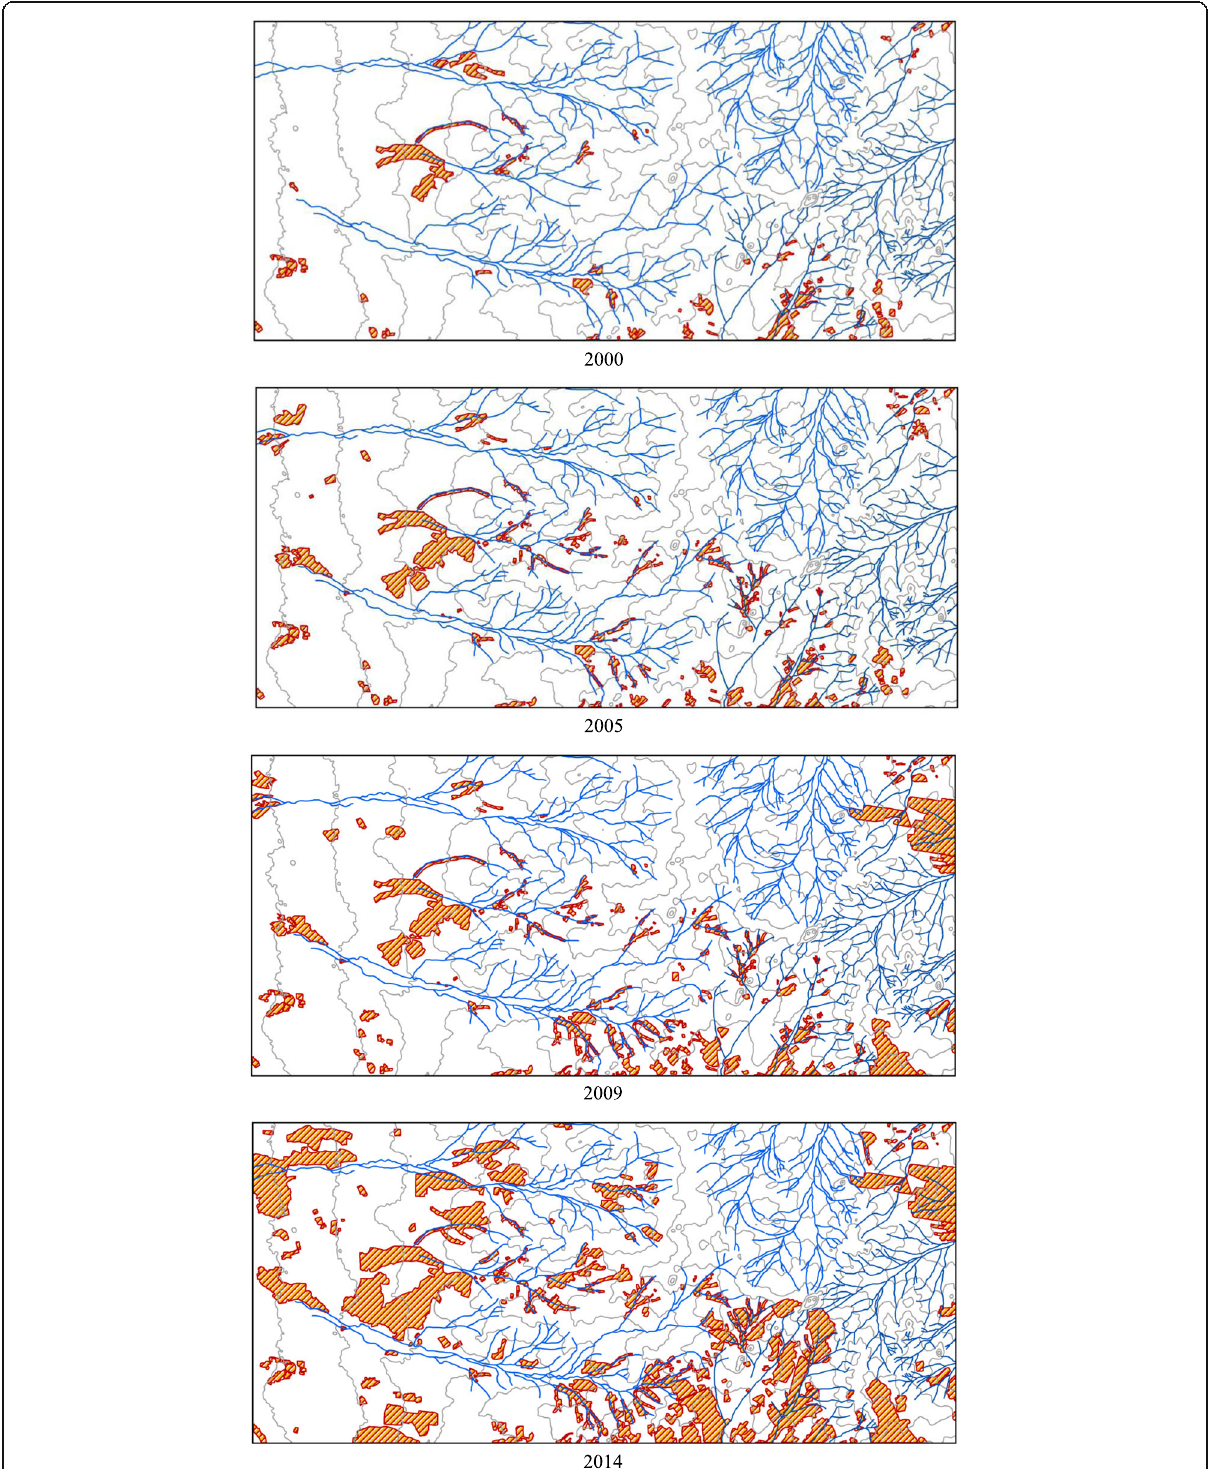
Figure 4 Spatial distribution LSMA in 2000, 2005, 2009, and 2014 in Butana